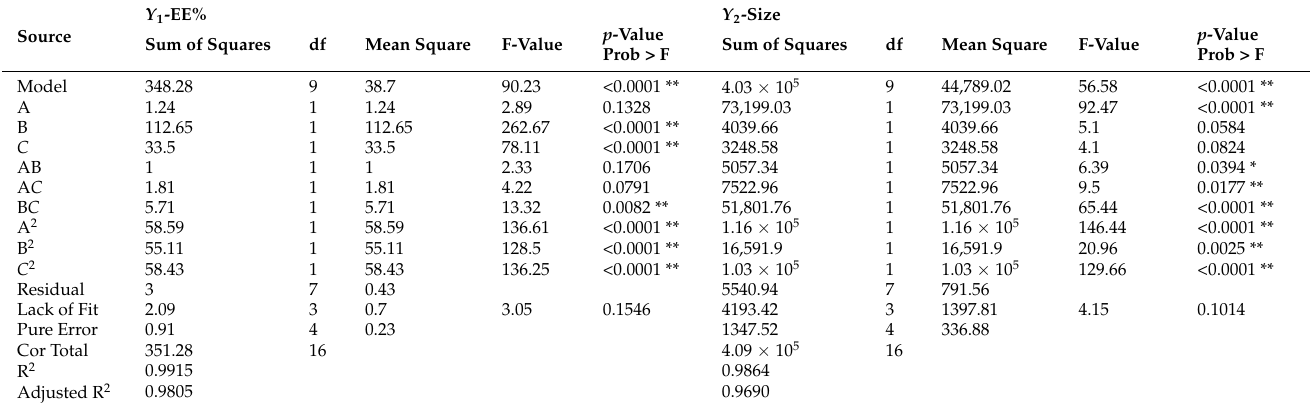
Table 3. Analysis of variance (ANOVA) of independent variable response surface